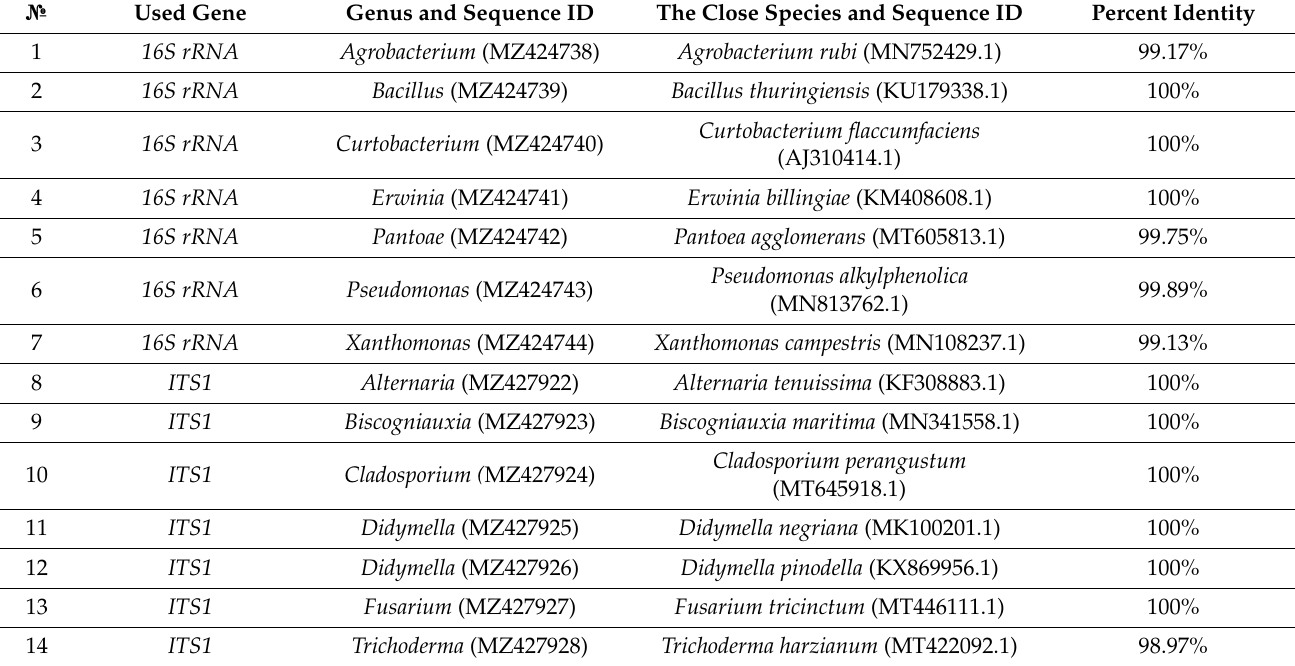
Table 1. Characteristics of the bacteria and fungi strains isolated from Vitis amurensis grape microbiome based on 16S rRNA (bacteria) gene or internal transcribed spacers ITS1 (fungi) sequences. The resulting nucleotide sequences were collected using the Staden Package program. The percentage identities of the collected nucleotide sequences were determined using NCBI BLAST (http://blast.ncbi.nlm.nih.gov; accessed date 11 May 2021) and the Nucleotide Blast (nucleotide—nucleotide BLAST)